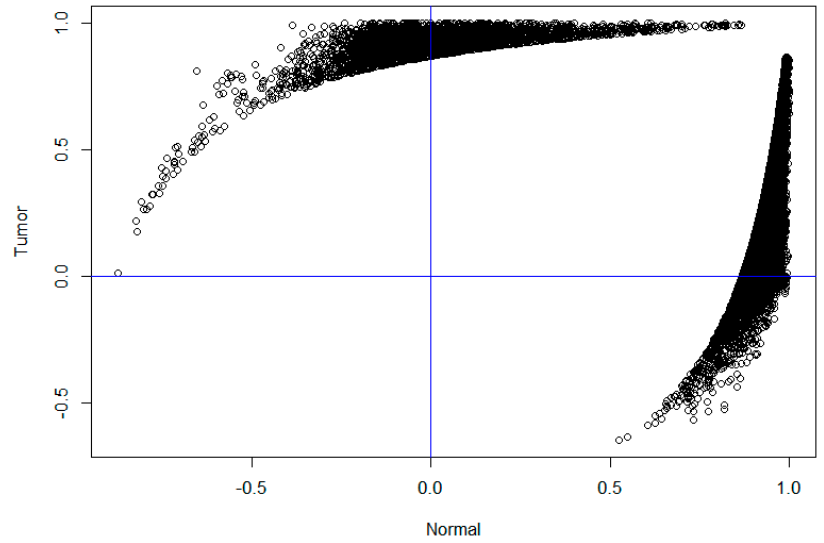
Figure 2. The correlation distribution of differentially co-expressed gene pairs. The X-axis represents the correlation coefficient of the differential co-expressed gene pairs in the healthy samples and the Y-axis represents the correlation coefficient of the differential co-expressed gene pairs in the tumor samples.